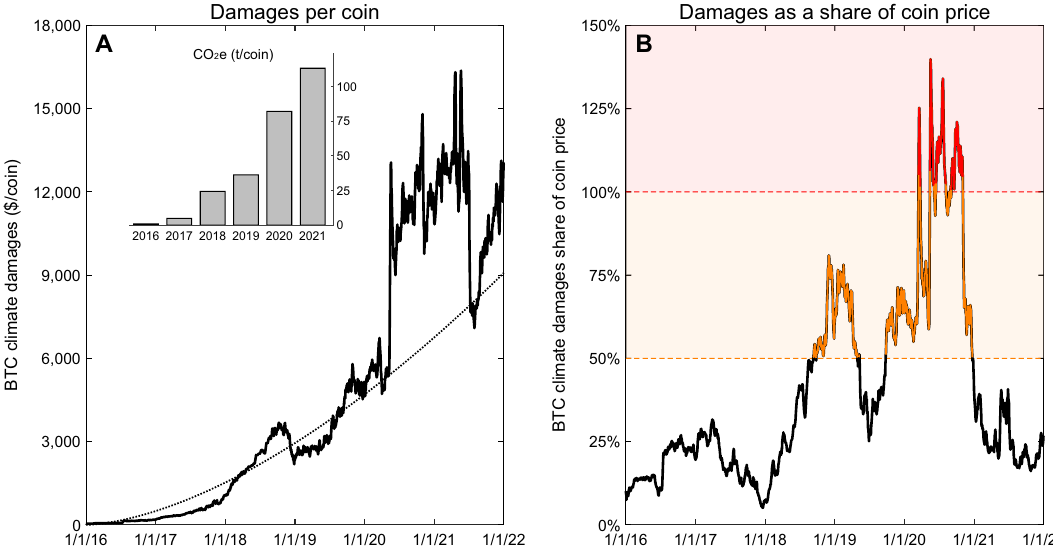
Figure 2. Global estimates of Bitcoin (BTC) mining’s climate damages, CO 2 e emissions, and climate damages as a share of coin price. ( A ) Estimated climate damages ($/coin mined) and CO 2 e emissions (t/coin mined; bar chart) of BTC. A non-linear trend line has been fit to the damages per coin data to illustrate time trends (dotted line). ( B ) Climate damages as a share of the coin’s price for BTC. Values displayed are the 7-days running average. Climate damages per coin mined in ( A ) were divided by the daily market price of the coin and multiplied by 100 to put into percentage terms for calculation in ( B ). $100 t −1 damage coefficient used for CO 2 e emissions based on ranges in the peer-reviewed literature. Damages are in US$. Estimates span January 1, 2016 to December 31, 2021. See the Supplementary Data for emissions factors used and the climate damages